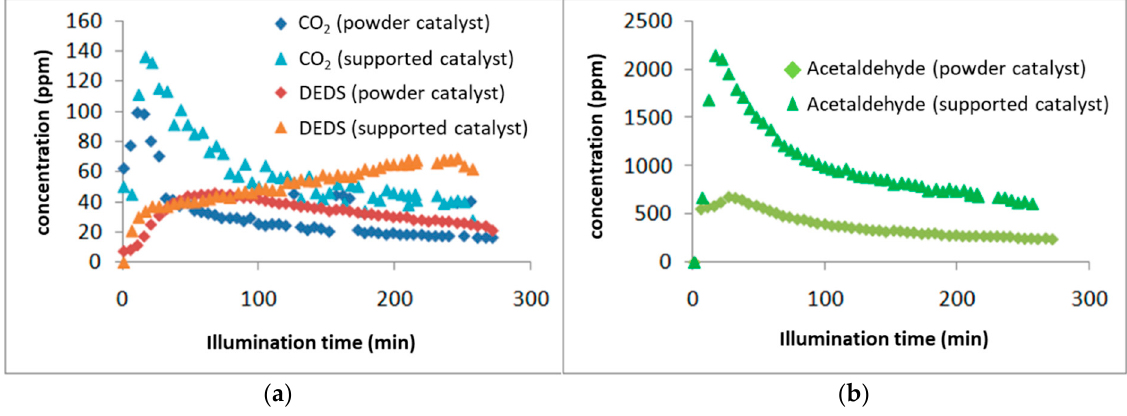
Figure 8. Evolution of CO 2 , DEDS ( a ) and MeCHO ( b )concentration as a function of the irradiation time during the degradation of DES by powdery and immobilized (on four foams pieces) TiO 2 P25 under UV-A illumination.